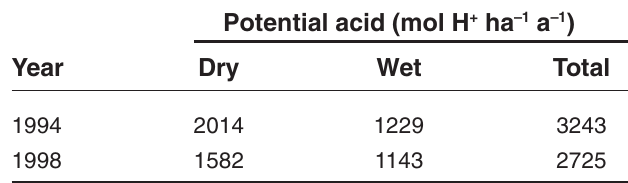
Total Potential Acid Deposition in 1994 and